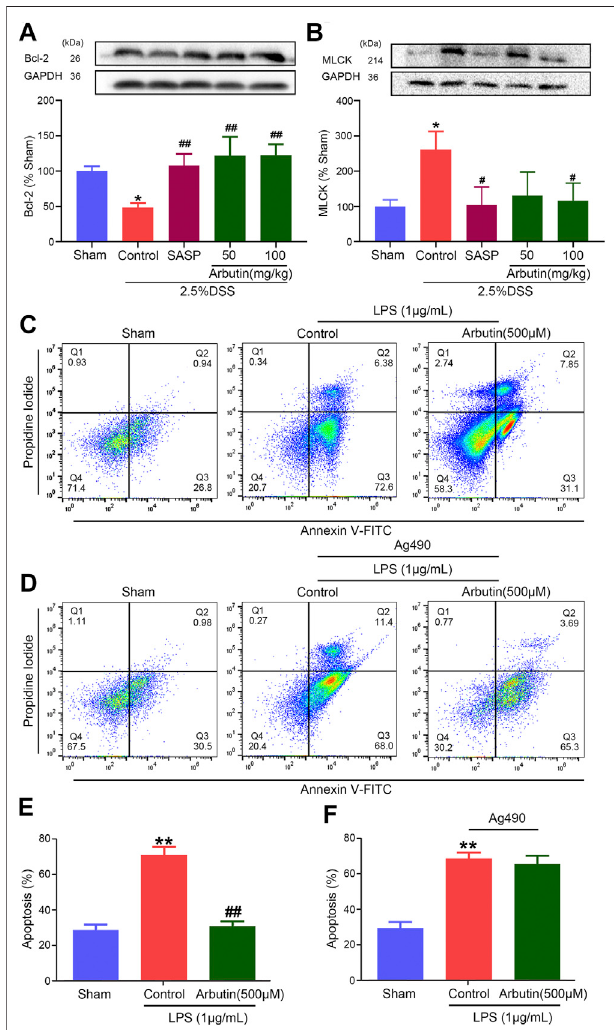
FIGURE 4 | Effects of arbutin on intestinal barrier dysfunction in colitis. Colon segments from mice were harvested and the expression of anti- apoptoticmarkerbcl-2 (A) andtightjunctionbarrierdysfunctionmarkerMLCK (B) were analyzed by Western blot analysis (C , E) IEC-6 cells were given arbutin (500 μ M) for 12 h after treatment with LPS (1 μ g/ml) for 12 h and the cell apoptosis was determined by fl ow cytometry (D , F) IEC-6 cells were pretreated with AG490 (50 μ M) for 1 h, treated with LPS (1 μ g/ml) for 12 h, and given arbutin (500 μ M) for 12 h. Then the cell apoptosis was detected by fl ow cytometry. Data were expressed as mean ± SD. ** p < 0.01 compared with sham group; # p < 0.05 compared with control group; ## p < 0.01 compared with control group. n (cid:1) 3 samples for Western blot